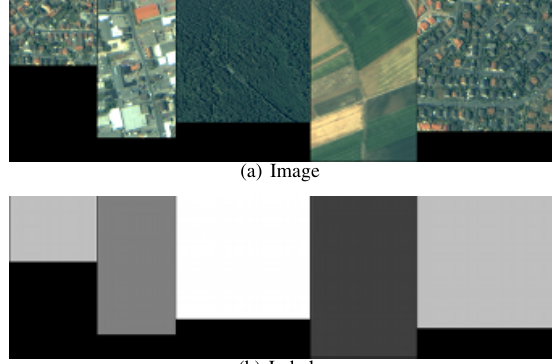
Figure 1: Training set T01 (a) with the accordant labels (b). Black are invalid regions not used as samples, grey values represent la- bels. Classes from left to right: c 4 , c 3 , c 2 , c 1 , c 4